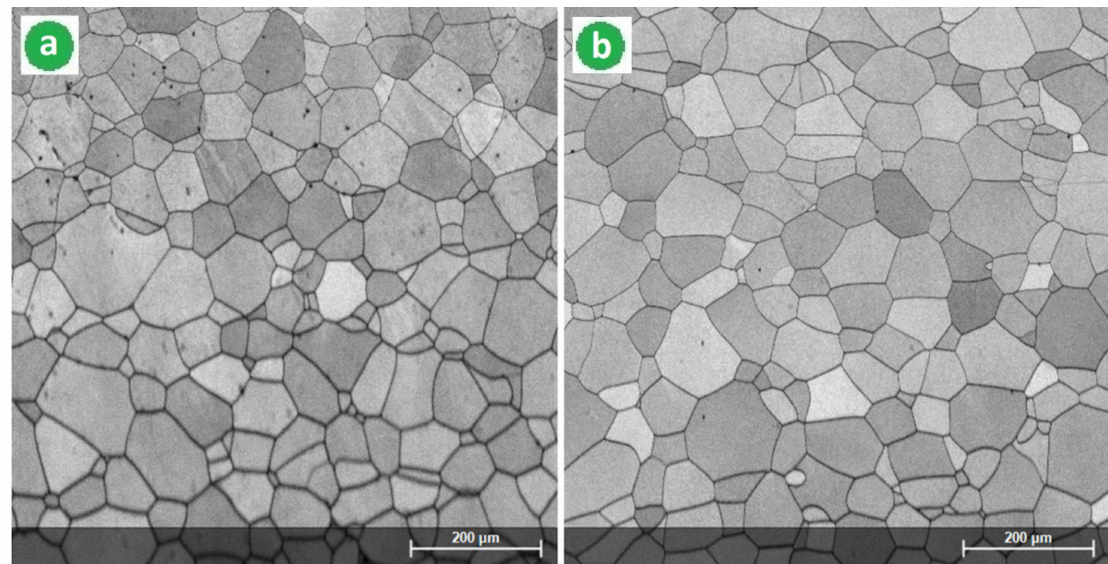
Figure 6. SEM-BSE images corresponding to the studied alloy after SPD and ST: ( a ) V-1: MPR ( ε tot = 90%) + ST1 (950 ◦ C- 10 min-w.q.); ( b ) V-2: MPR ( ε tot = 90%) + ST2 (950 ◦ C-20